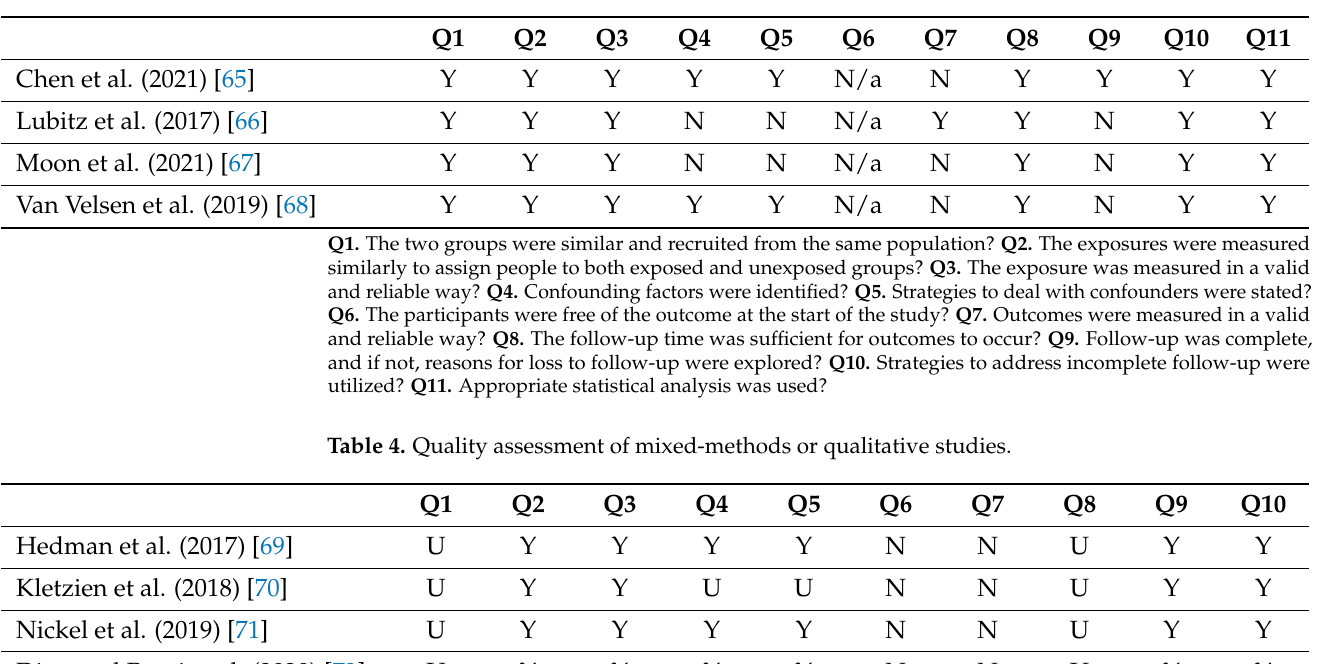
Table 3. Quality assessment of cohort studies.